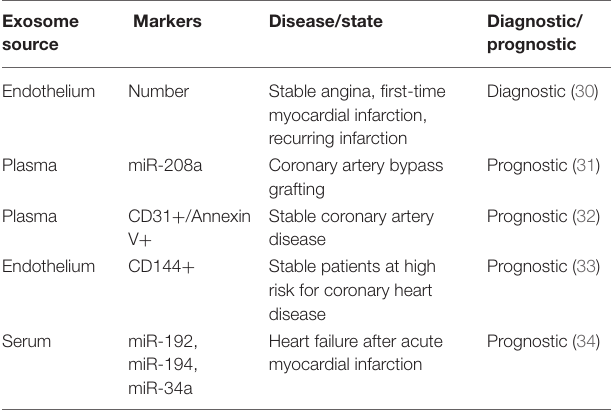
TABLE 2 | Summary of exosomes as potential biomarkers in cardiovascular